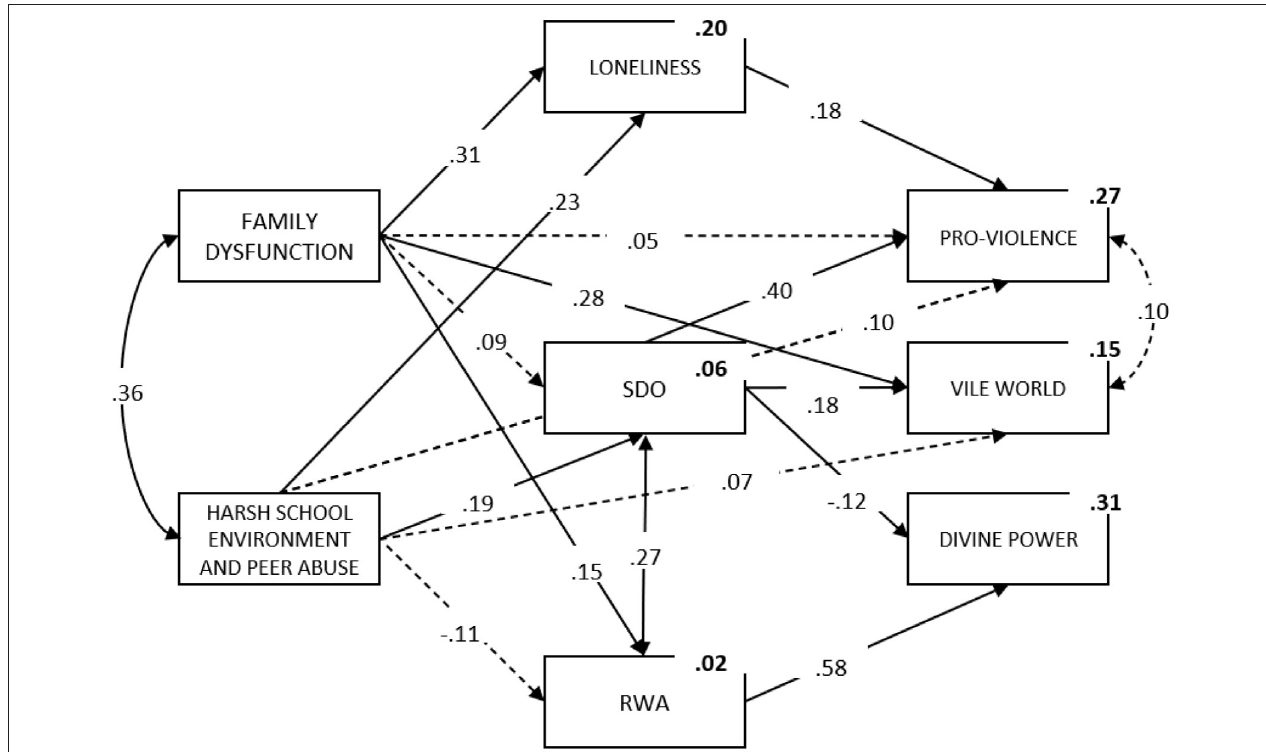
FIGURE 1 | Prediction of MEM. Statistically significant coefficients are marked by full arrows; Squared multiple correlations are shown in bold